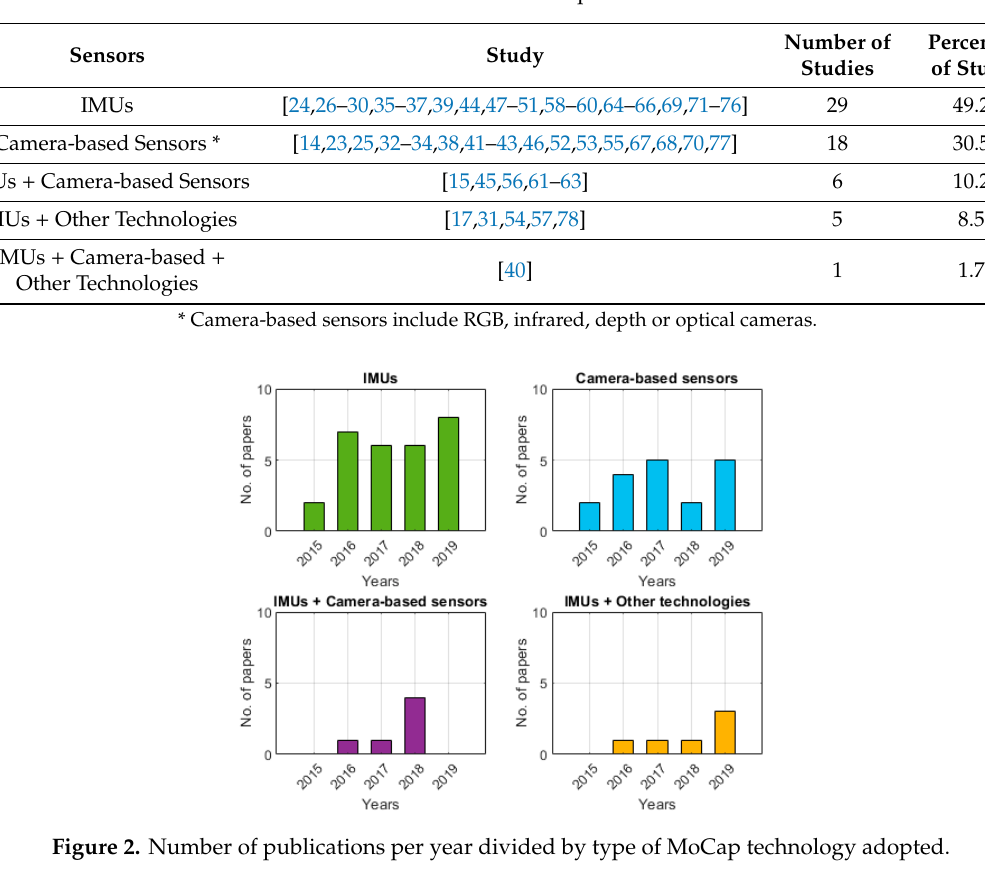
Table 4. Characteristics of the most used MoCap